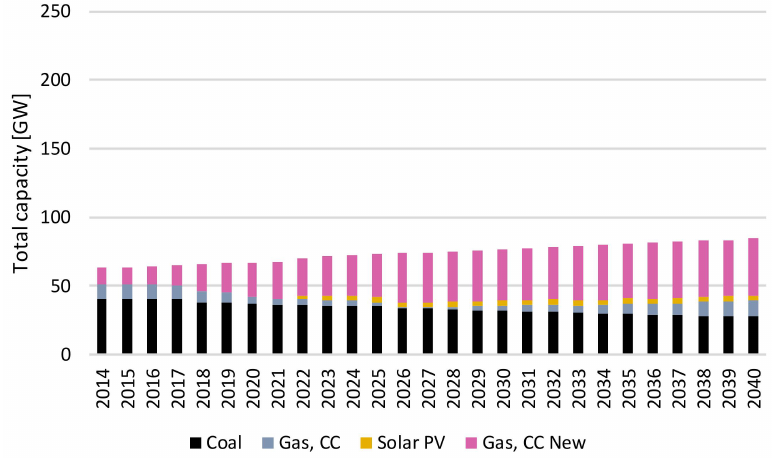
Figure 9. Total capacity (GW) in the REF scenario—with code modifications.